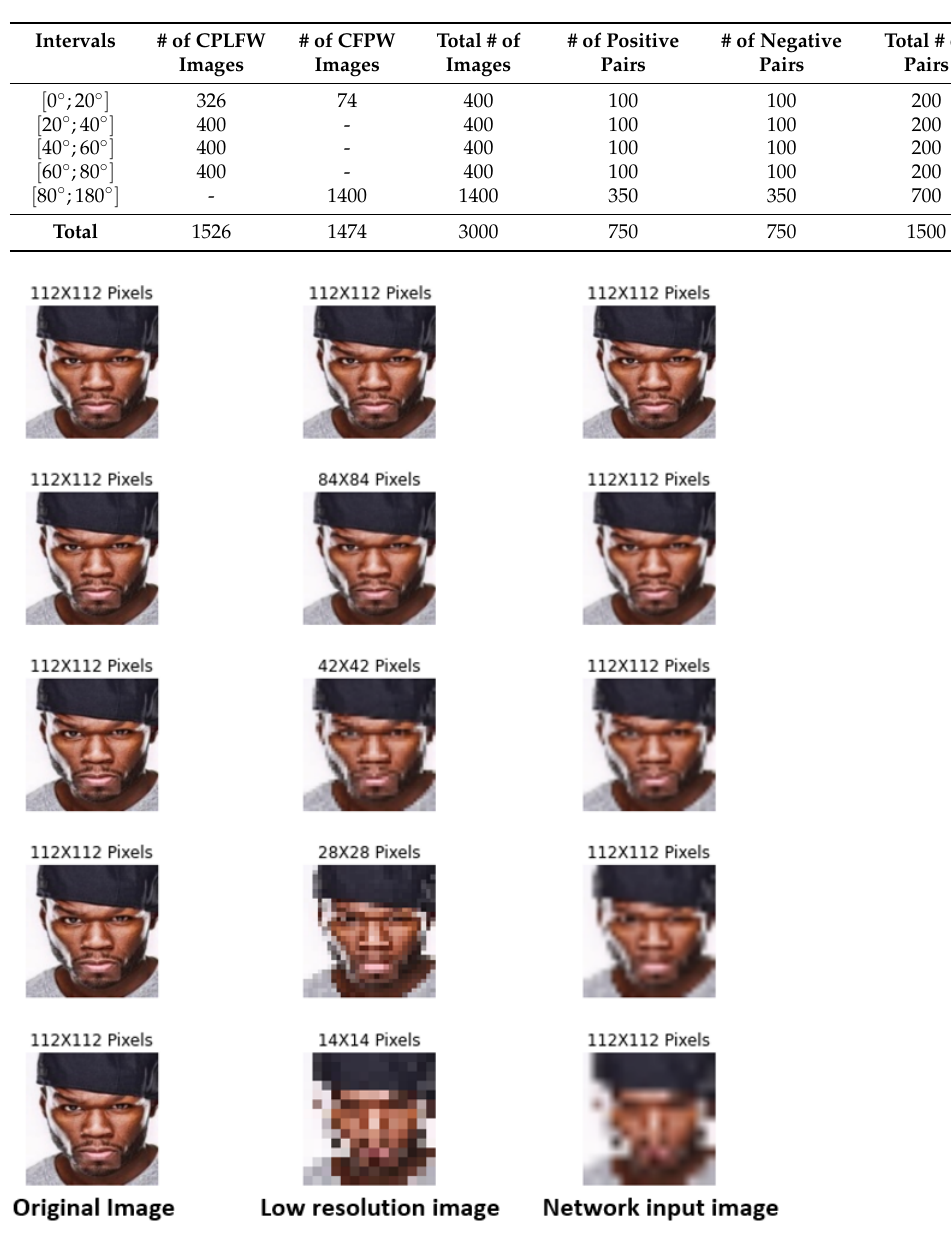
Figure 5. Example of the five levels of resolution in the proposed evaluation subset.